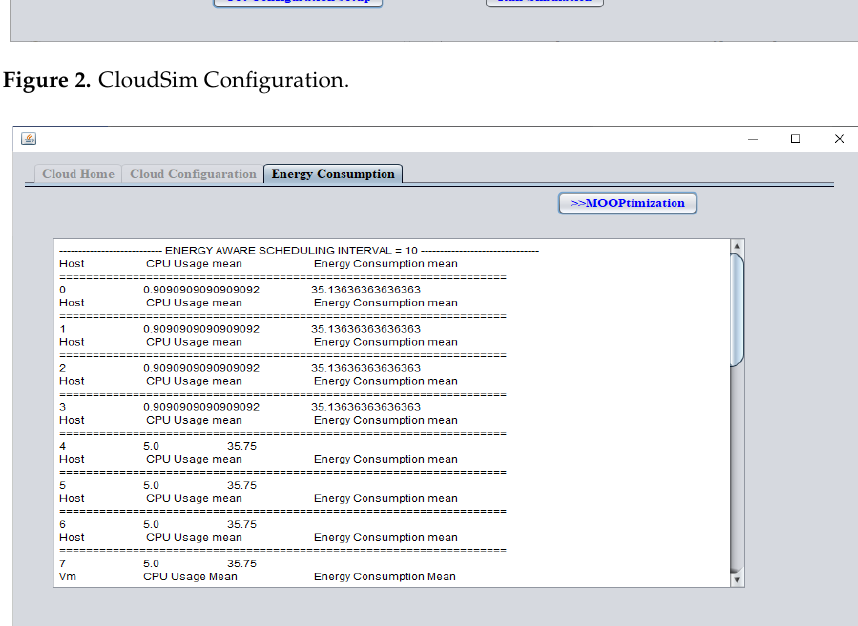
Figure 3. Energy consumption of HM and VM.